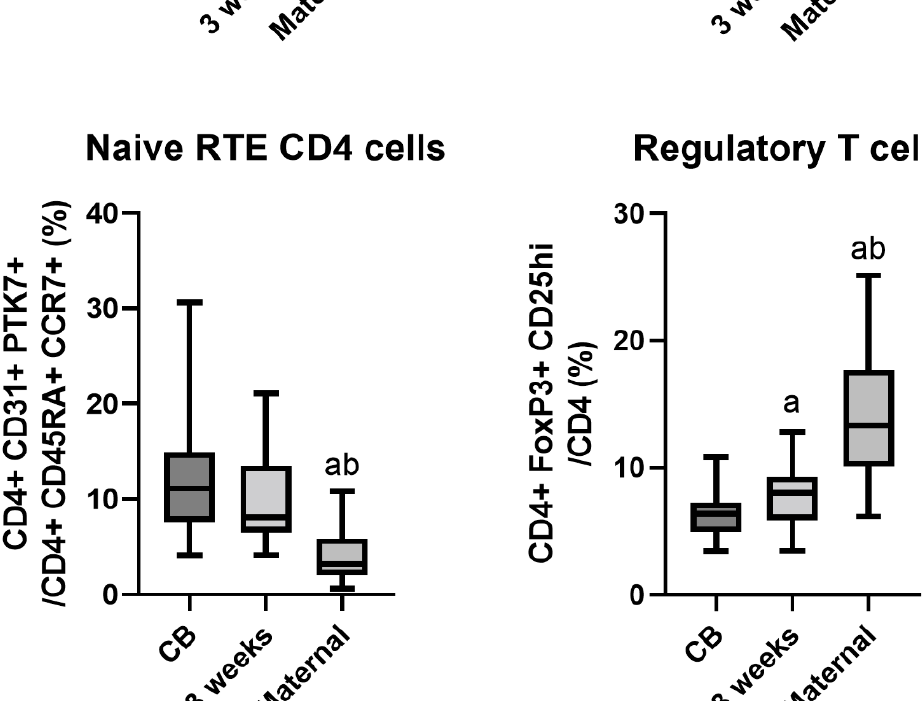
Figure 1. The proportion of investigated cell subsets in cord blood (CB), neonatal blood at three weeks of age, and maternal blood ( n = 19 in each group). p < 0.05 vs. a—CB, b—three weeks. Line — median, box—quartiles, whiskers — range.